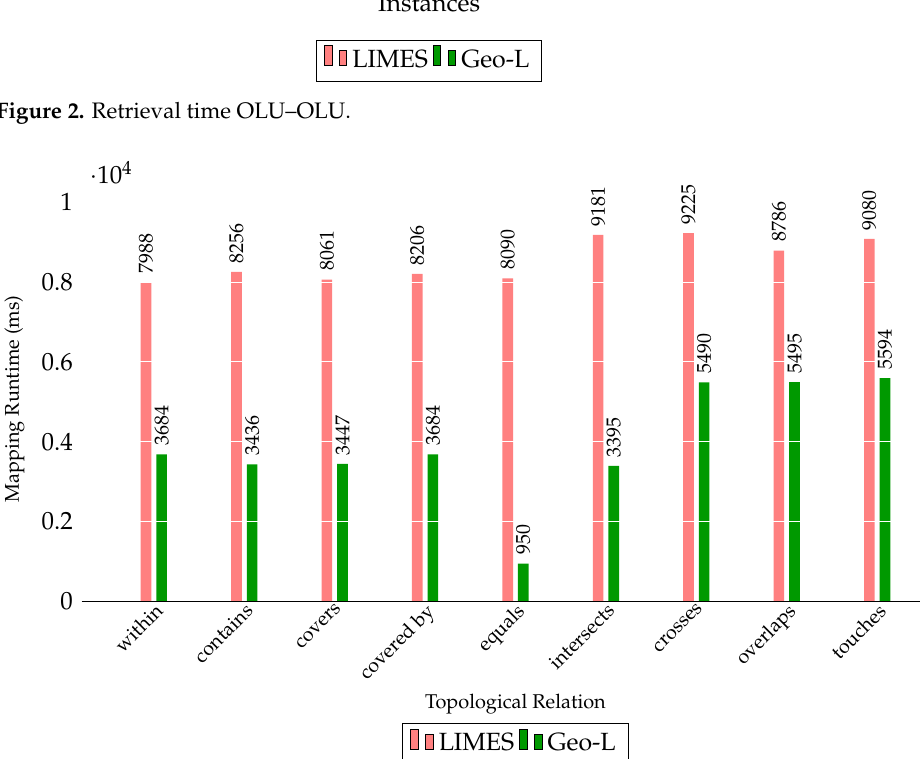
Figure 3. Performance OLU–OLU; size: 165 · 10 3 × 165 · 10 3